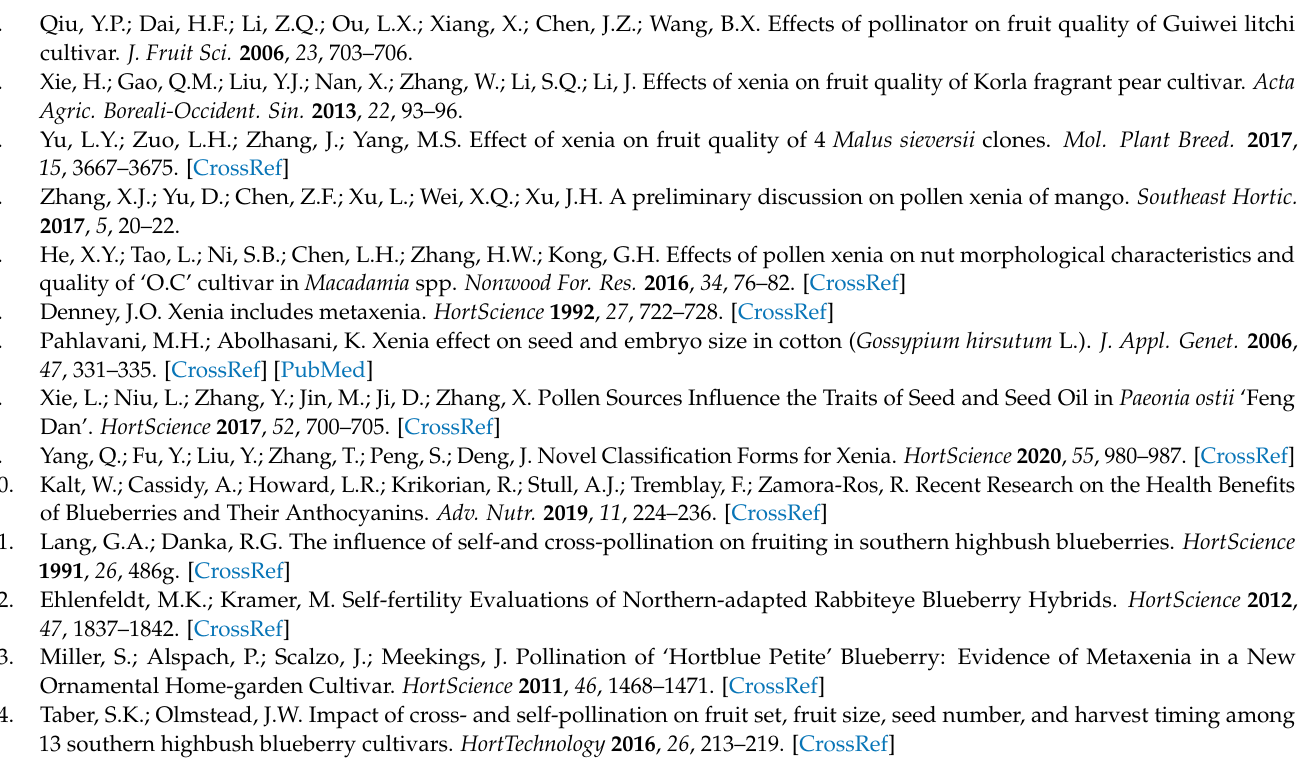
contribution rate of each principal component, Table S8: Component loading table for ‘Emerald’ and ‘O’Neal’ as the maternal